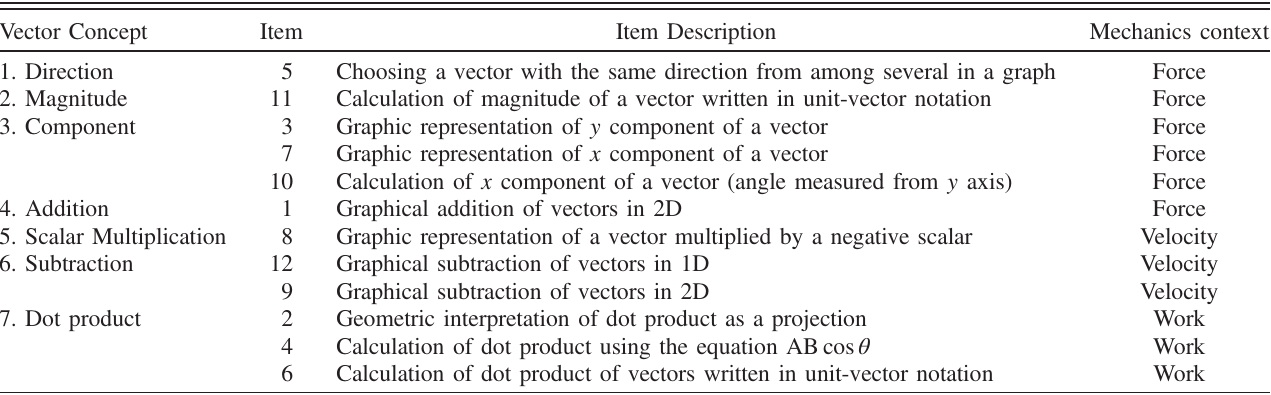
TABLE II. Description of both tests used in this study. Vector